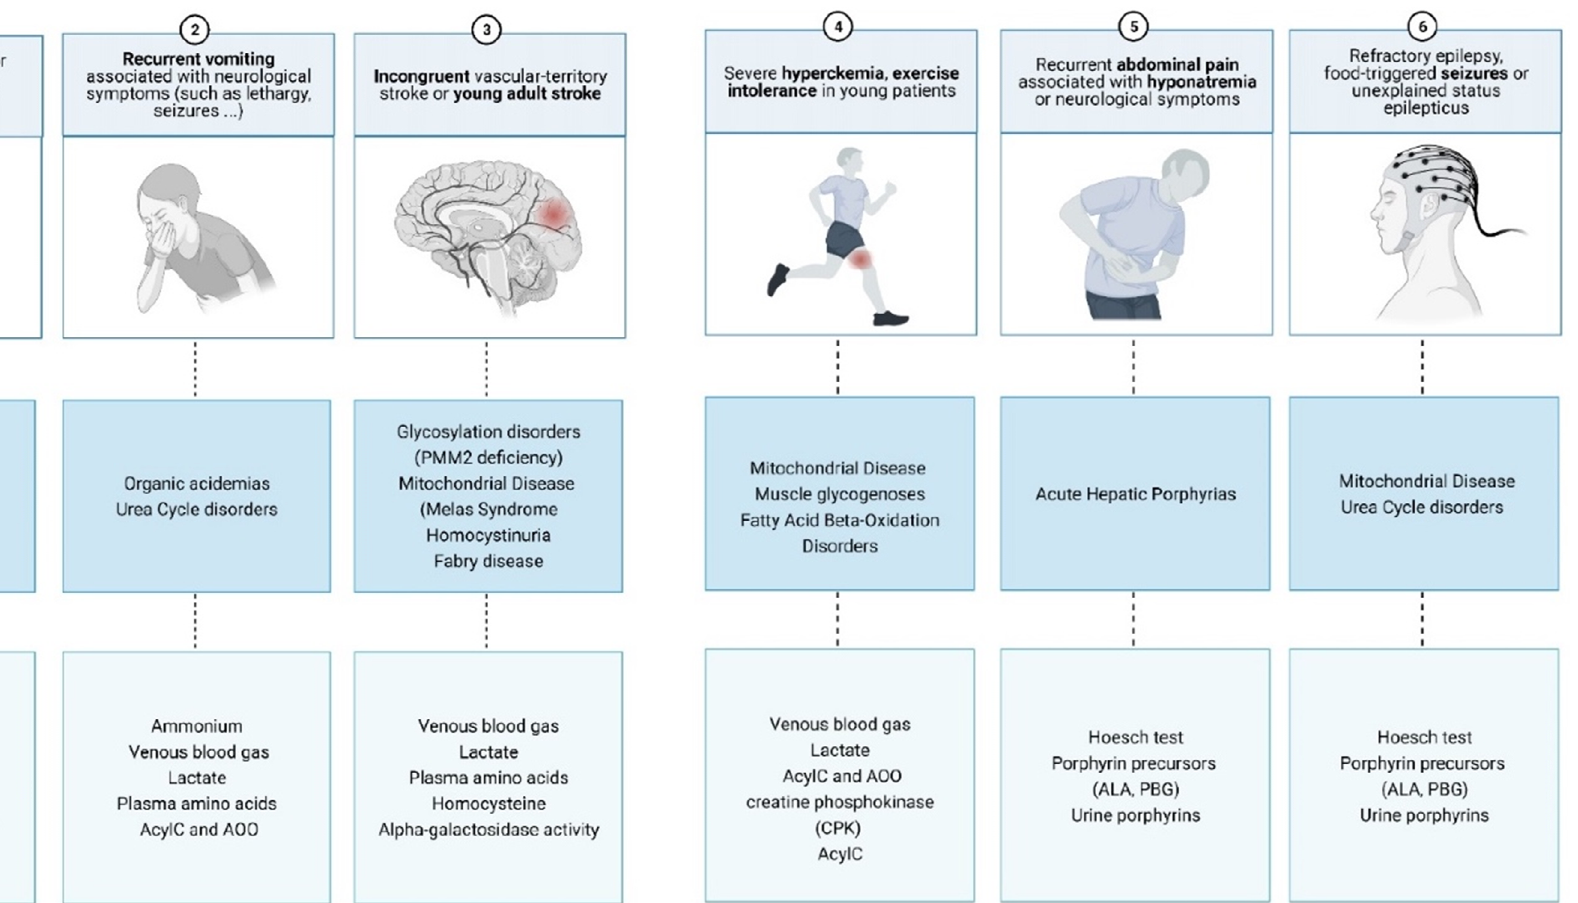
Figure 1. How to address a suspected inborn error of metabolism error in the emergency department.